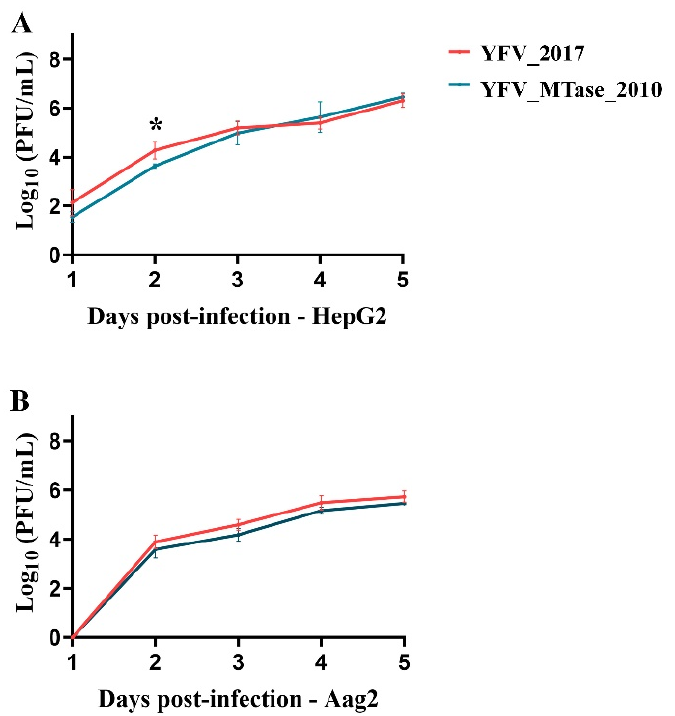
Figure 4. Viral yields of YFV_2017 and the YFV_MTase_2010 viruses in infected ( A ) HepG2 cells and